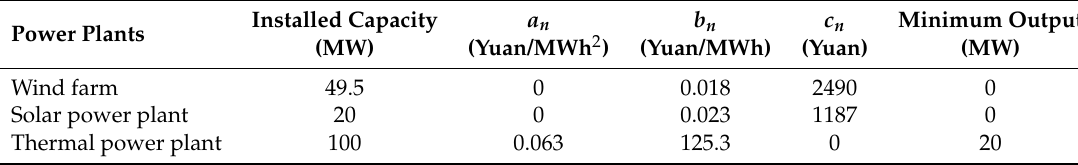
Table 1. Generation parameters of power plants.